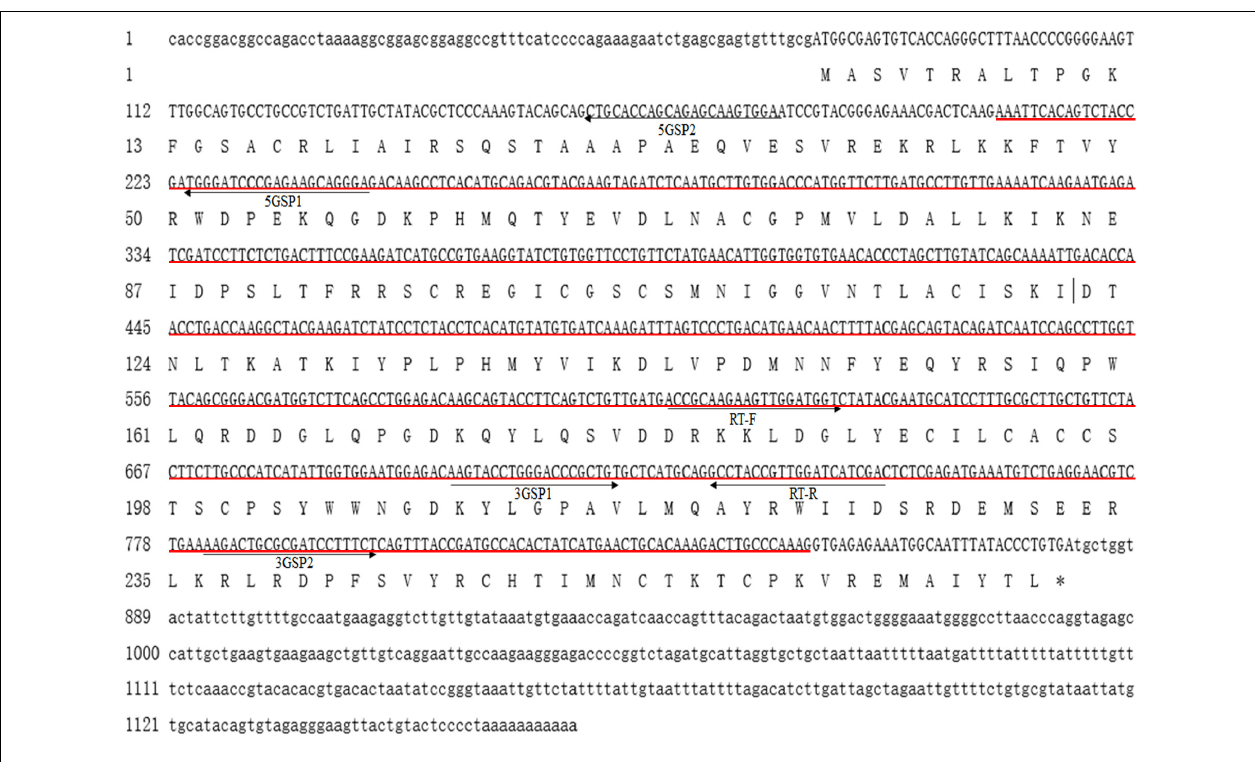
FIGURE 1 | Nucleotide and deduced amino acid sequence of Mn-SDHB . The nucleotide sequence is displayed in the 5 (cid:48) –3 (cid:48) directions and numbered at the left. The deduced amino acid sequence is shown in a single capital letter amino acid code. 3 (cid:48) UTR and 5 (cid:48) UTR are shown with lowercase letters. Codons are numbered at the left with the methionine (ATG) initiation codon, an asterisk denotes the termination codon (TGA). Red line indicated the PLN00129 superfamily.